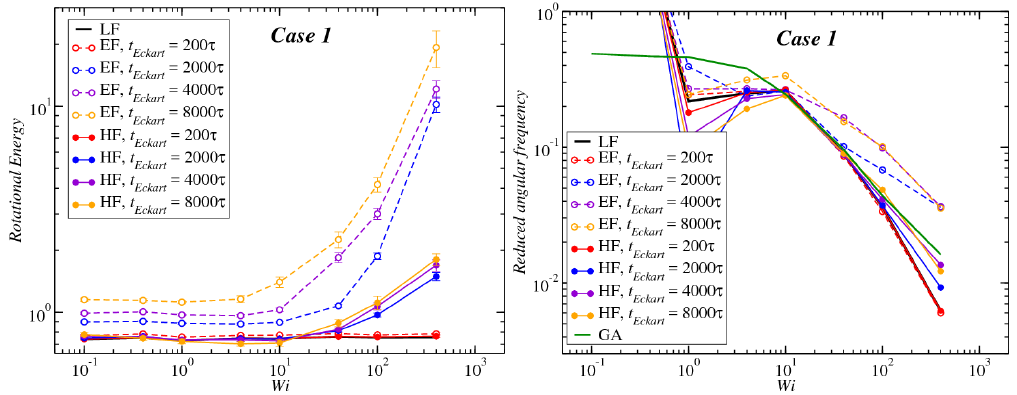
Ω · ˆJ · Ω , HF → 1 W · ˆJ · W ) for the ω · J · ω , EF → 1 2 2 2